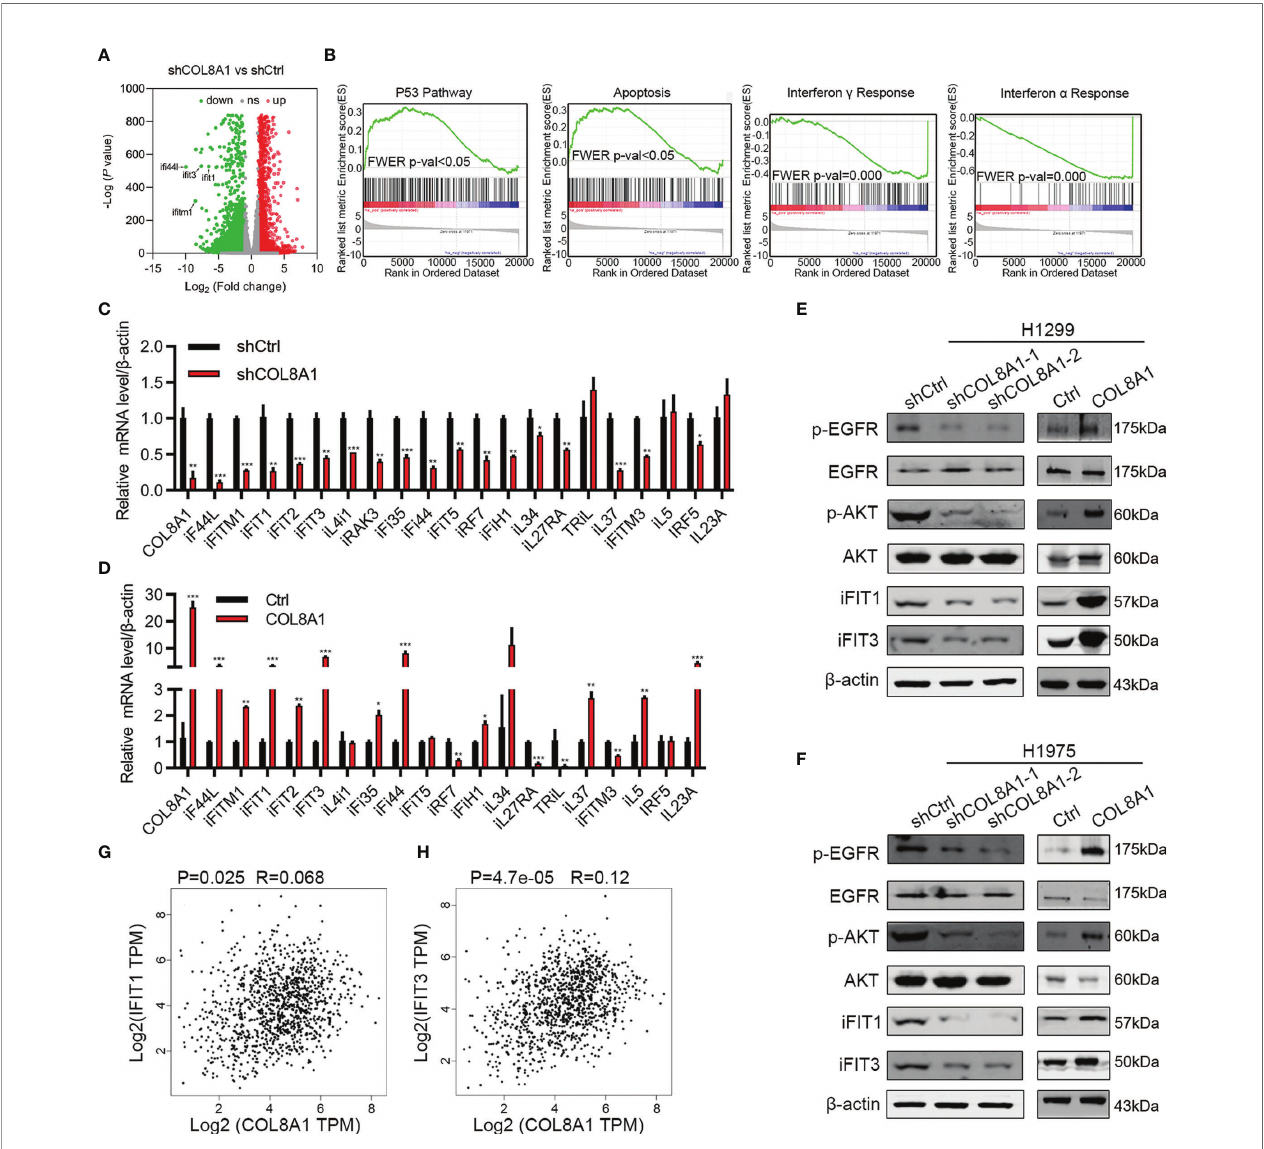
FIGURE 4 | COL8A1 stimulates IFIT1 and IFIT3 expression and EGFR activity in NSCLC cells. (A) RNA-seq data showing dysregulated genes in COL8A1-silenced NSCLC cells compared with shCtrl cells. (B) Gene set enrichment analysis (GSEA) of genes regulated in COL8A1-silenced and control cells. (C, D) qRT-PCR analysis of dysregulated genes in COL8A1-silenced and COL8A1-overexpressing cells. (E, F) Western blot evaluation of the effects of COL8A1-silencing and COL8A1-overexpression on the IFIT pathway and EGFR activity in NSCLC cells. (G, H) Correlation analysis between COL8A1 and IFIT1 or IFIT3 expression. *p < 0.05. **p < 0.01. ***p <